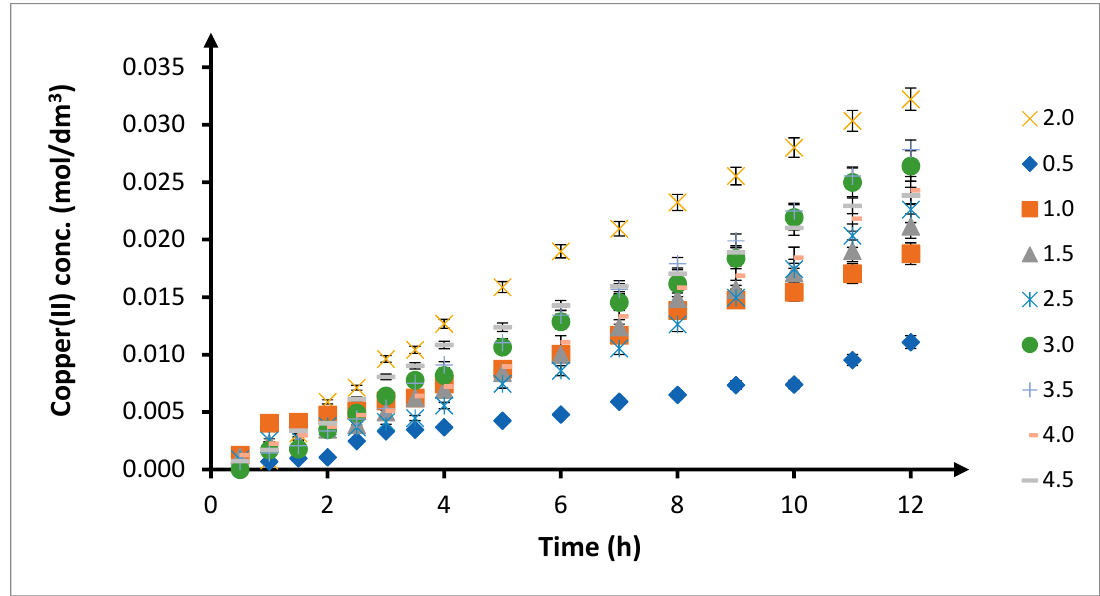
Figure 3. Change in concentration of copper(II) in receiving phase over time depending on volumetric flow rate of phase in spiral module. Flow rate: 0.5–4.5 cm 3 / min; feed phase: CuCl 2 concentration = 0.1 mol / dm 3 , chloride concentration = 2.0 mol / dm 3 ; receiving phase: demineralized water; and membrane: CTA-ONPOE-TRIA-10. The composition of the membrane is given in Table 2. Temperature: 20 ± 0.5 °C.